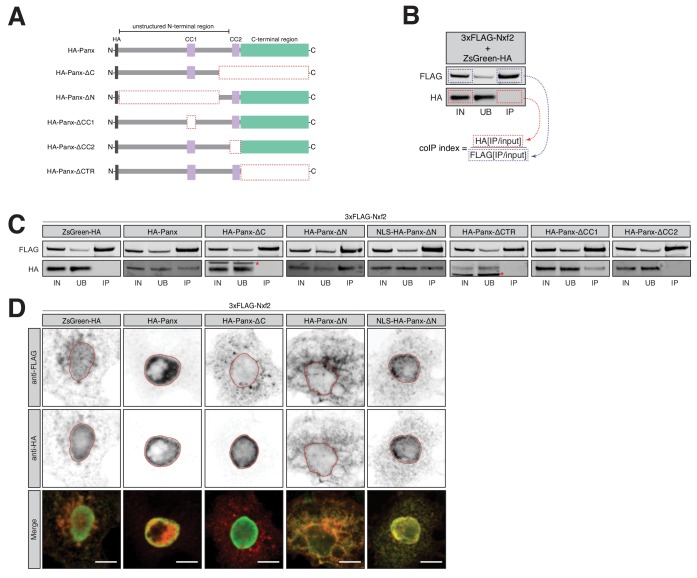
Interaction between Nxf2 and Panx is required for proper transposon silencing.(A) Cartoons displaying the Panx protein structure and domain mutants used in panels (C) and (D). CC, coiled coil domain; HA, Hemagglutinin tag. (B) Representative western blot displaying calculation of Co-immunoprecipitation (coIP) index from HA IP and input signals as well as FLAG IP and input signals. (C) Western blot analyses of FLAG-tag co-immunoprecipitation from lysates of S2 cells transfected with the indicated expression constructs (IN, input; UB, unbound; IP, immunoprecipitate). Asterisk indicates unspecific band from anti-HA antibody. (D) Expression and localization of full-length Nxf2 (3xFLAG-tagged, top, shown in red in the merge) and the indicated Panx (HA-tagged, bottom, shown in green in the merge) expression constructs in transfected S2 cells are shown by immunofluorescence. Lamin staining (red lines) was used to draw the outline of the nuclear envelope. Scale bar, 5 µm.